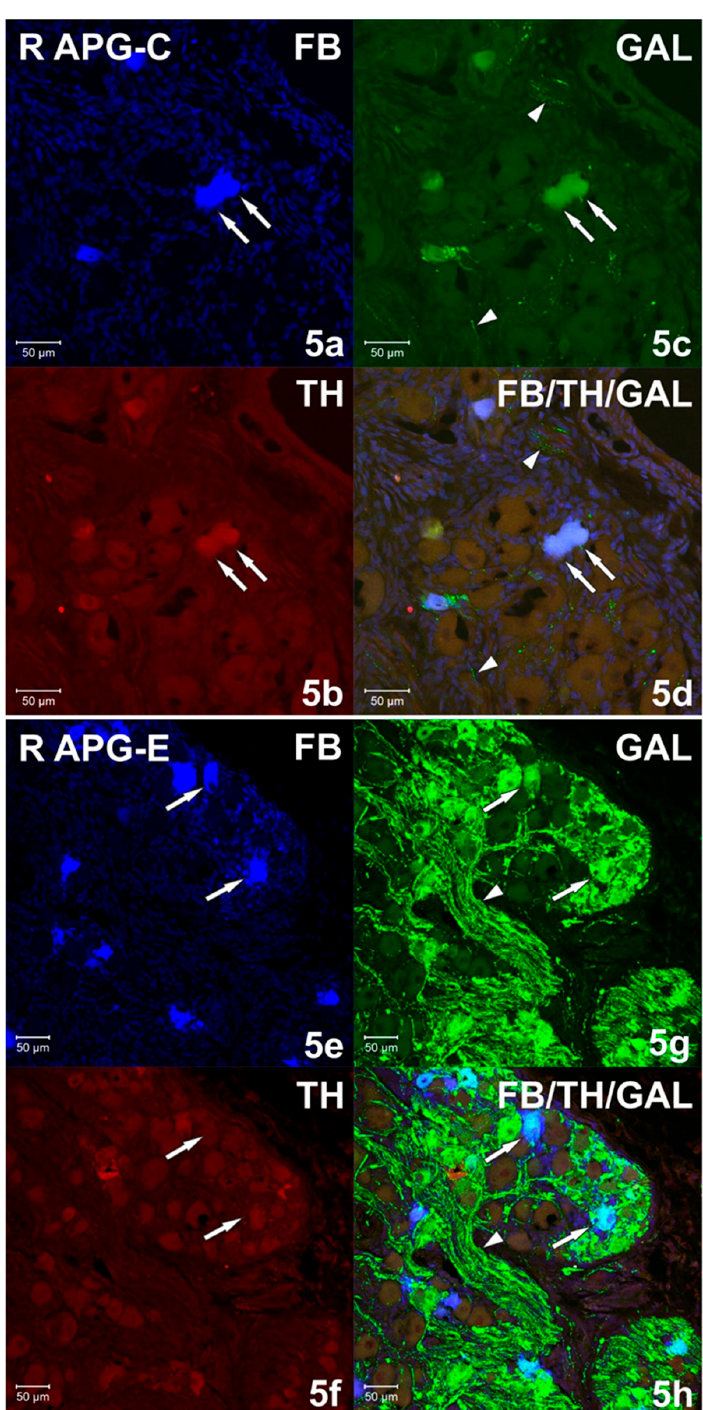
Figure 5. ( a – d ) Confocal laser scanning microscope images showing a section of the right (R) APG from the control (C) group. FB+ ( a ) neurons simultaneously immunoreactive ( d ) against TH ( b ) and galanin (GAL) ( c ) marked with arrows. The arrows indicate single, varicose GAL-IR fibers ( c , d ). The images were taken from blue, green and red fluorescent channels. Blue, green and red channels were digitally superimposed. Scale bar = 50 µm. ( e – h ) Confocal laser scanning microscope images showing a section of the right (R) APG from the experimental (E) group. Arrows indicate FB+ ( e ) GAL-positive ( g ) neurons, but no TH-IR ( f ). Very numerous GAL-IR fibers ( g , h ) marked with an arrowhead. The images were taken from blue, green and red fluorescent channels. Blue, green and red channels were digitally superimposed. Scale bar = 50 µm.